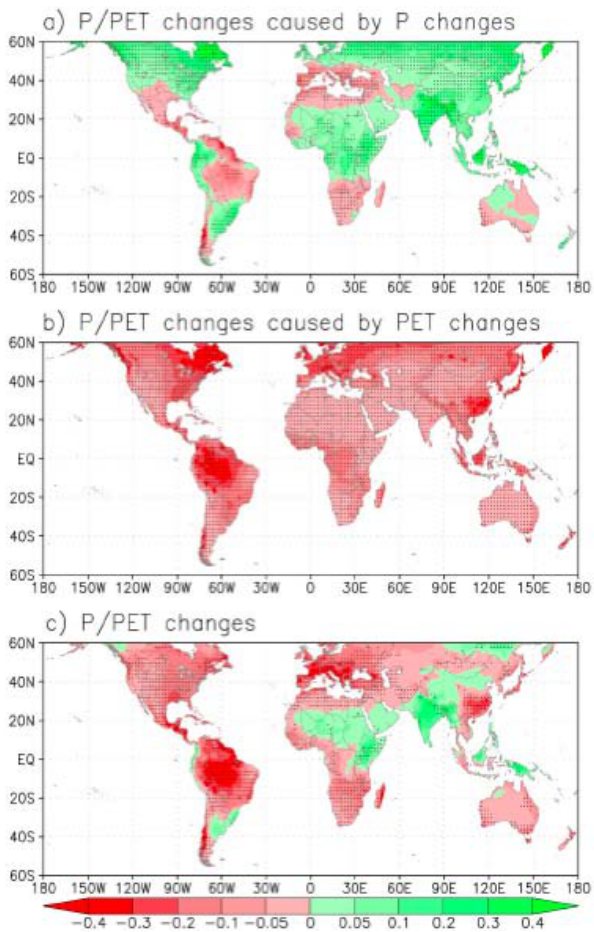
Fig. 8. Contributions of (a) precipitation and (b) PET to (c) pro- jected changes in P /PET for 2071–2100 relative to 1961–1990 un- der scenario RCP85 from 27 climate models. Grid points are stip- pled where more than 80% of these models agree on the sign.